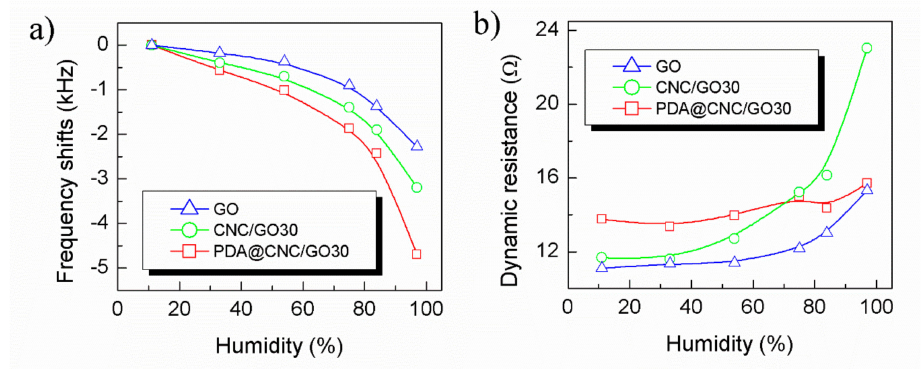
Figure 5. ( a ) Frequency shifts; and ( b ) dynamic resistance of GO-, CNC / GO30-